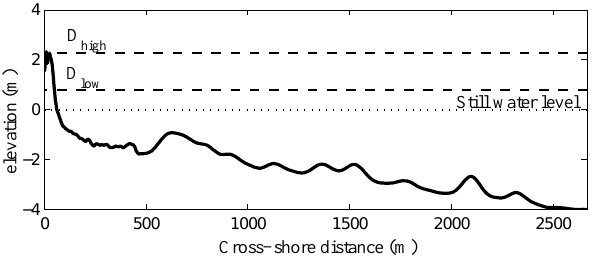
Figure 2. Beach profile indicating the dune crest ( D high = 2.27m) and dune base ( D low = 0.8m) elevations with respect to still water